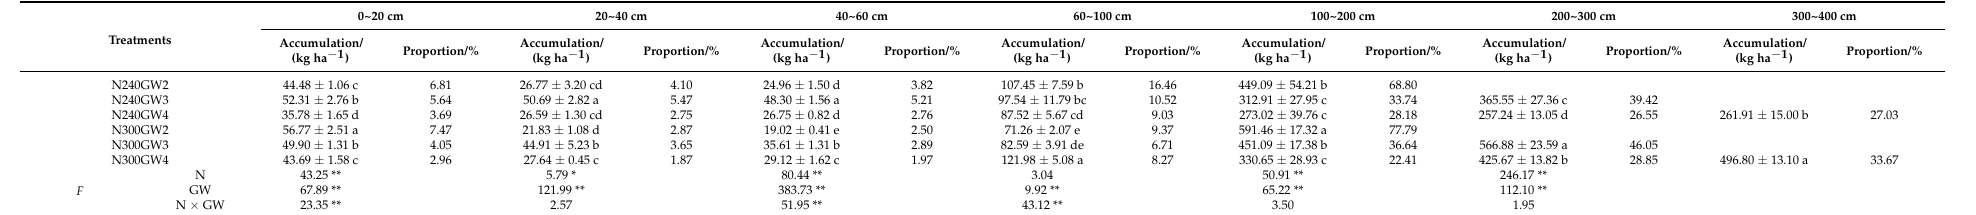
Table 4. Residual soil nitrate accumulation in each soil layer in summer maize.